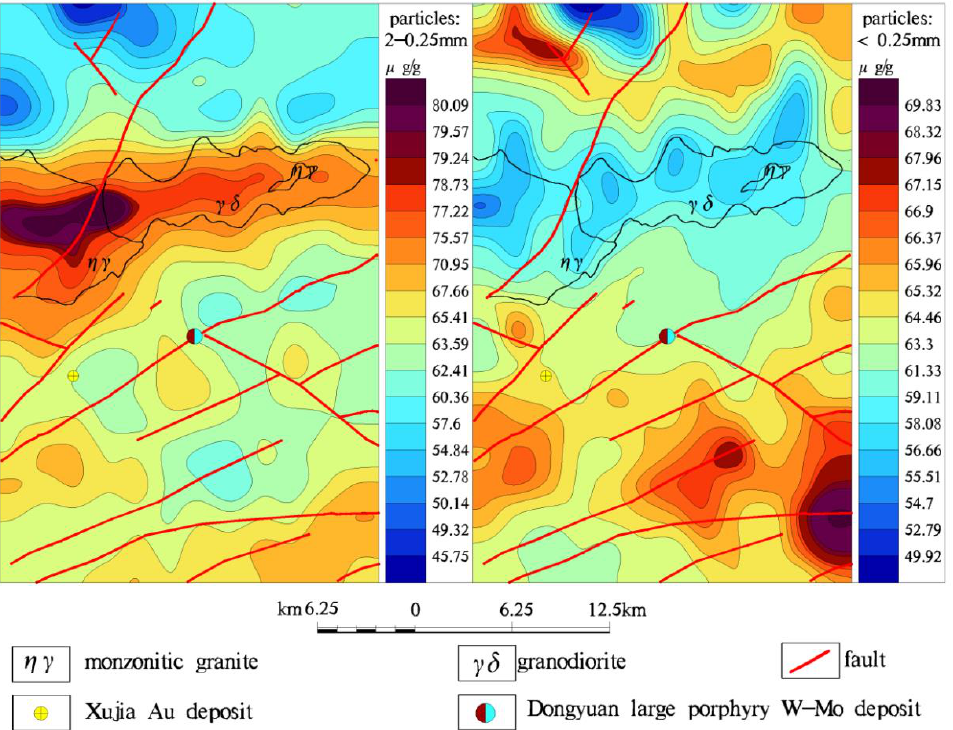
Figure 7. Geochemical maps of SiO 2 in 0.25–2 mm and <0.25 mm fraction of stream sediments in the pilot area.